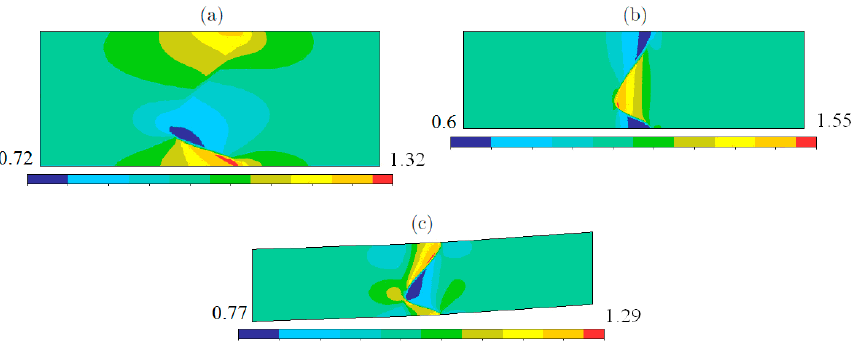
Figure 6. The von Mises stress concentration in the vicinity of symmetric weld: ( a ) tension along Ox -axis, ( b ) tension along Oy -axis, ( c ) shift.